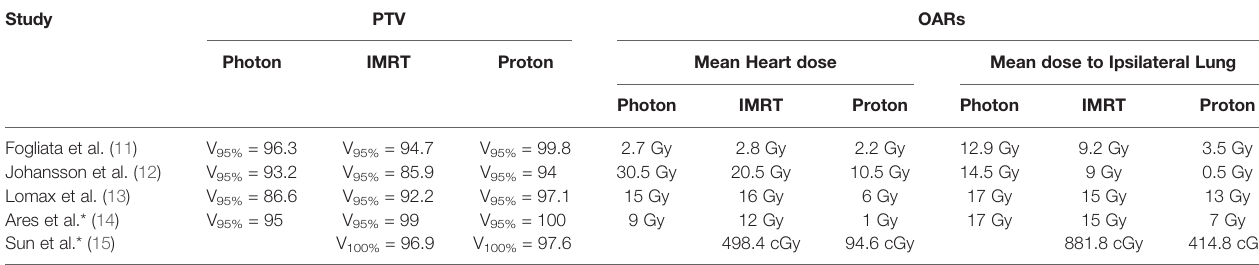
TABLE 1 | Overview of dose-volume histograms for breast target coverage (PTV) and adjacent critical organs in the proton-photon planning comparison literature.